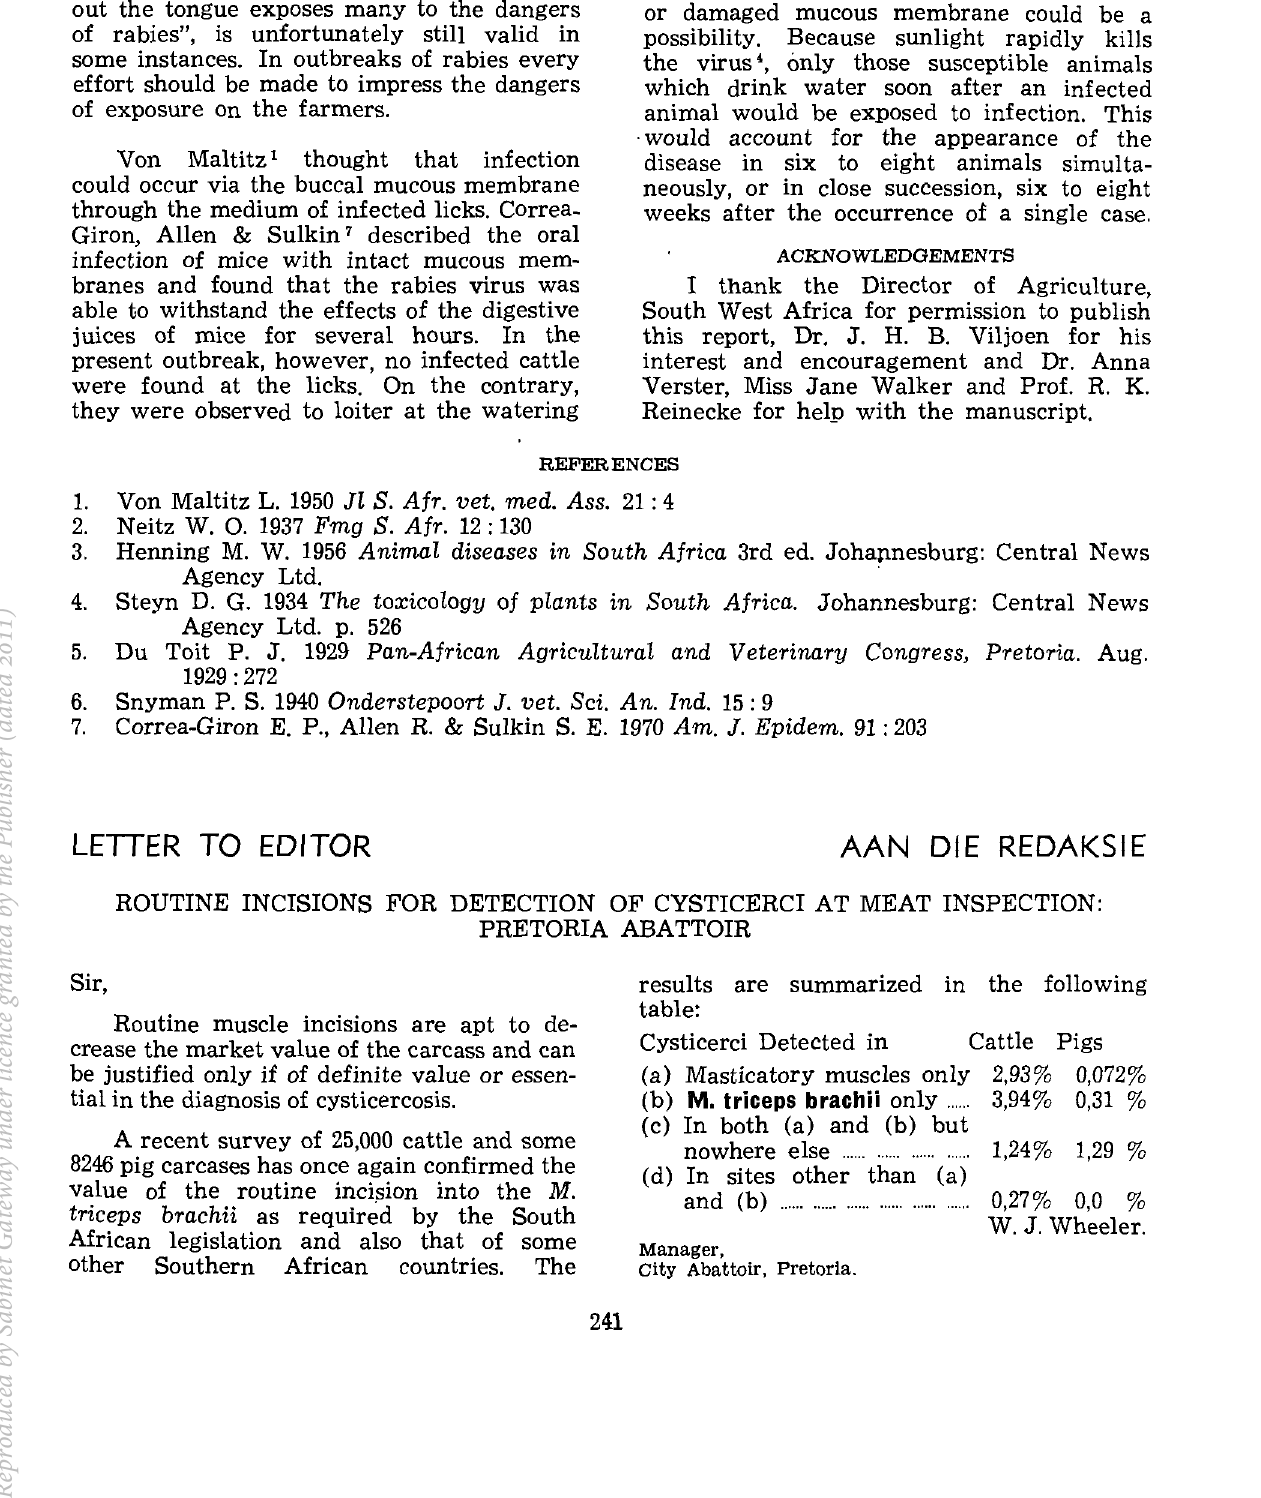
ROUTINE INCISIONS FOR DETECTION OF CYSTICERCI AT MEAT INSPECTION: PRETORIA ABATTOIR